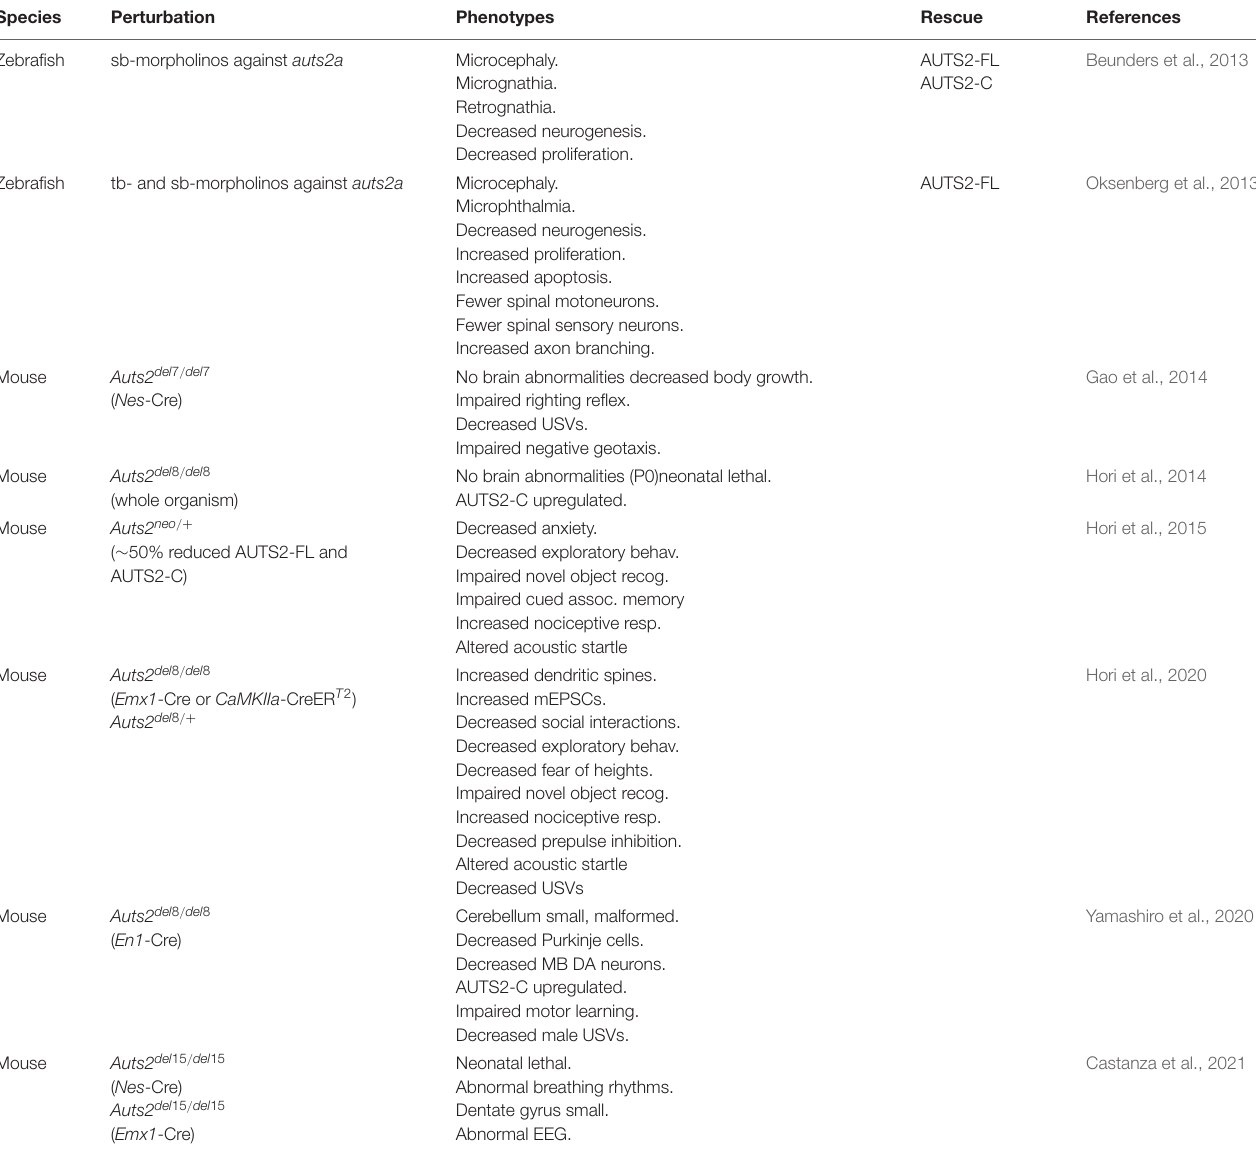
TABLE 2 | Animal models of AUTS2